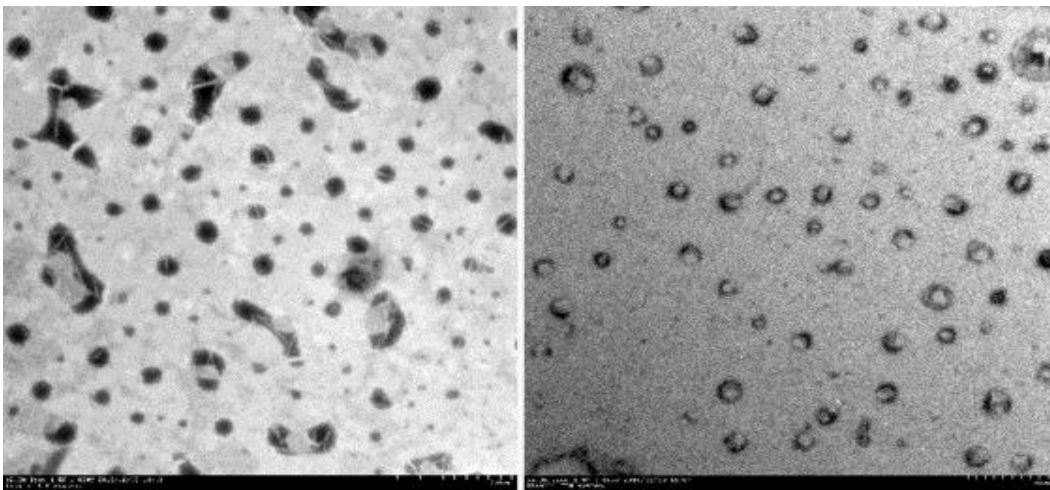
Figure 2. TE micrograph of transfersomes showing hollow nanovesicles. Reproduced from Reference [54] with permission.